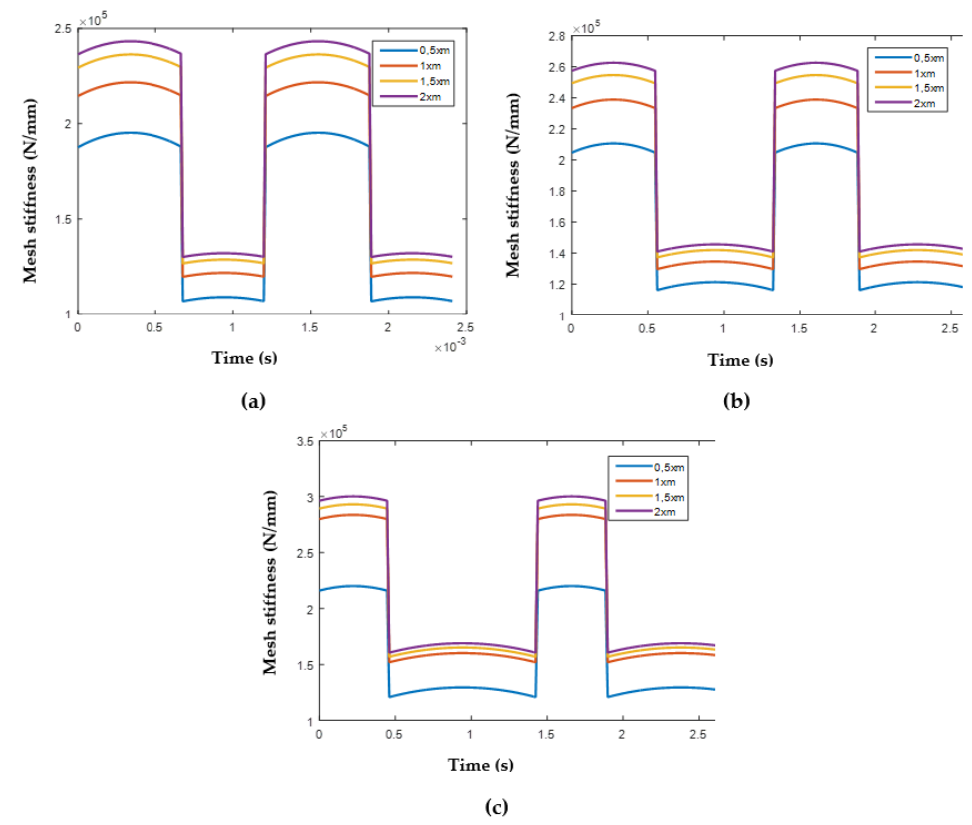
Figure 24. MS results of hybrid gears with different DSPAs: ( a ) 20°, ( b ) 25°, ( c )